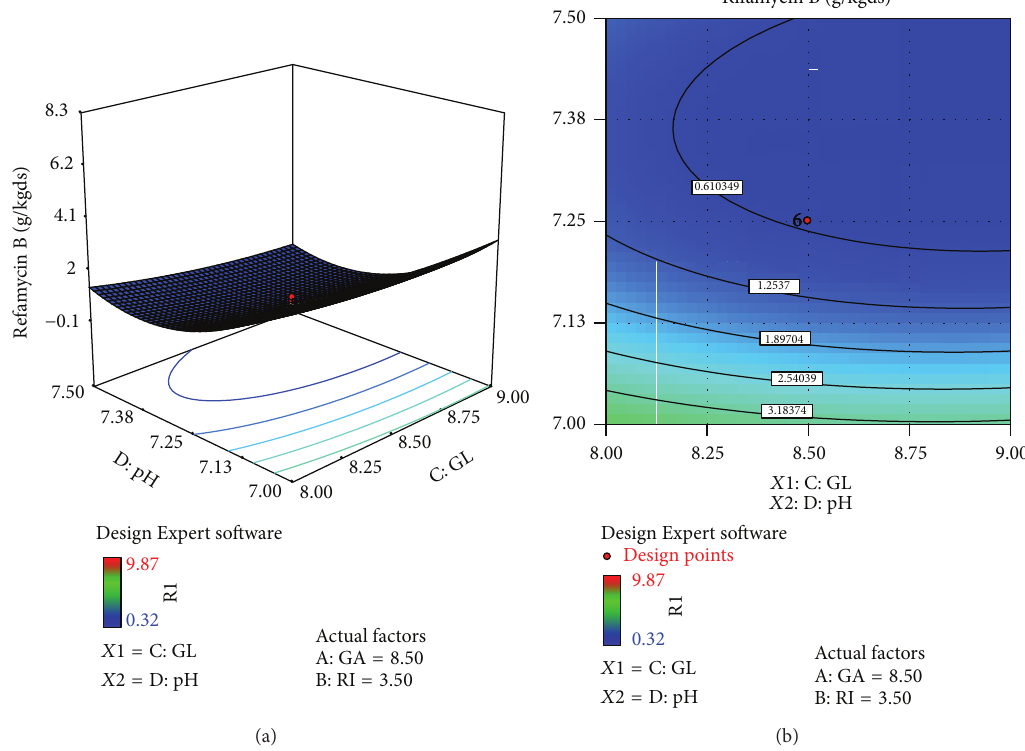
Figure 12: Surface and contour plot for rifamycin B production at varying levels of 𝑋1 , glucose (GL), and 𝑋10 ,